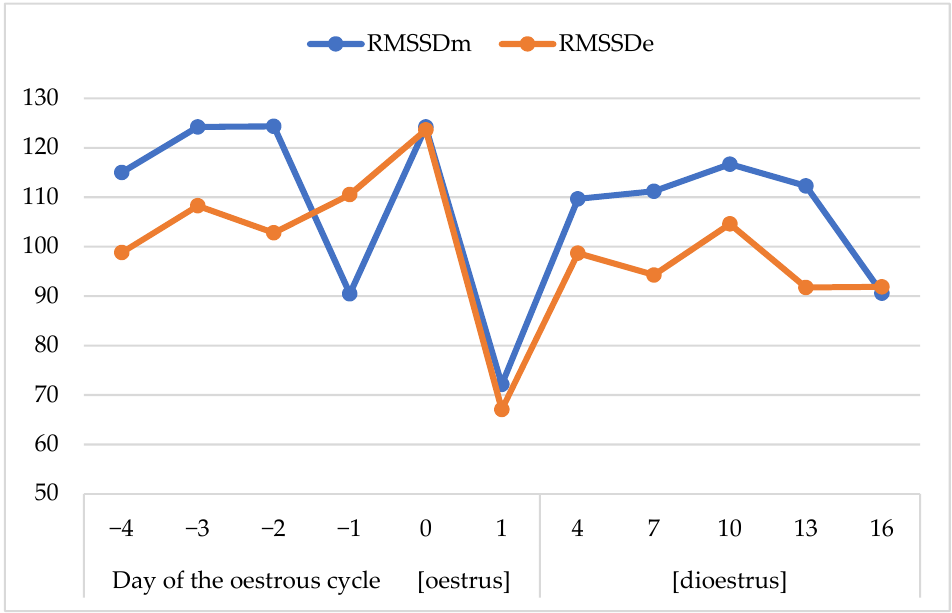
Figure 2. Dynamics of RMSSD changes in the morning and evening during the oestrous cycle. RMSSD— root mean square of successive differences in beat-to-beat intervals (ms).